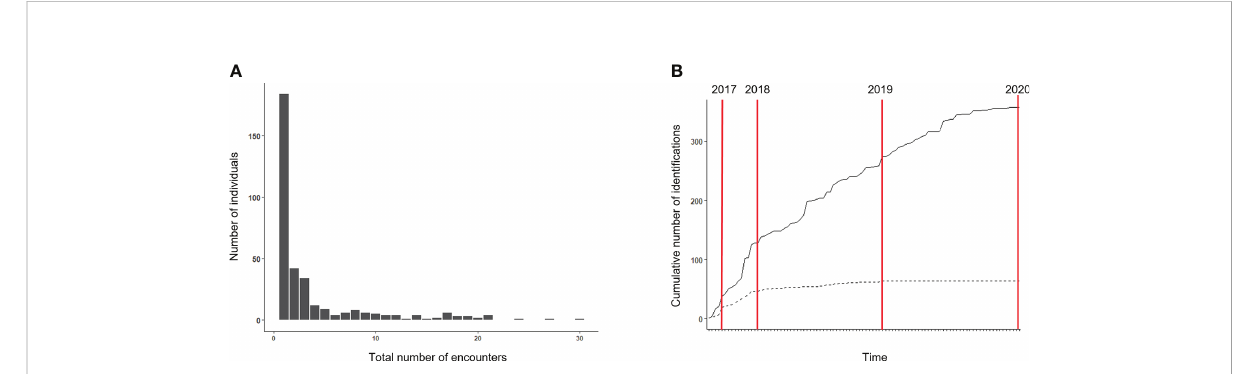
FIGURE 2 (A) Frequency distribution of the number of encounters of individual bottlenose dolphins. (B) Cumulative discovery curves for bottlenose dolphin individuals over the study period. The solid line shows the discovery curve for the overall 347 individuals identi fi ed; the broken line represents the discovery curve for the 68 individuals seen at least fi ve